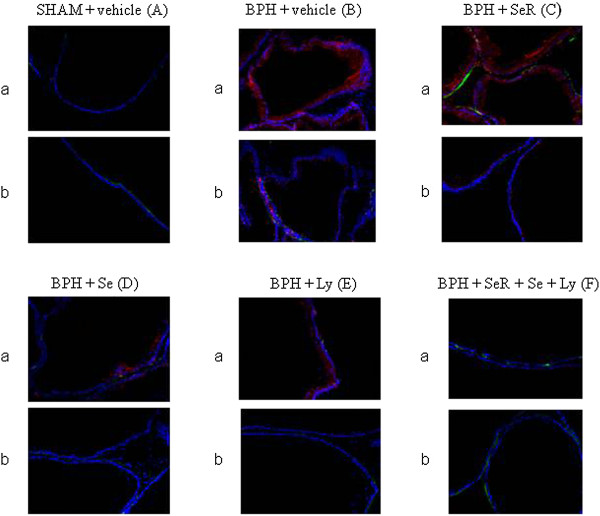
Immunofluorescence analysis of NAIP and Survivin. Immunofluorescence stainings of NAIP (a) and Survivin (b) (in red) and anti-smooth muscle alpha-actin (in green) showed a diffuse positivity in BPH prostatic epithelium treated with vehicle (B). In a lesser extent, the fluorescence was present in BPH prostate treated with SeR, Se and Ly, in a decremental fashion (C, D and E). Differently, NAIP and Survivin were just focally or not detected in Sham and BPH prostate treated with the combination SeR-Se-Ly (A and F, respectively) (Original magnification ×400).